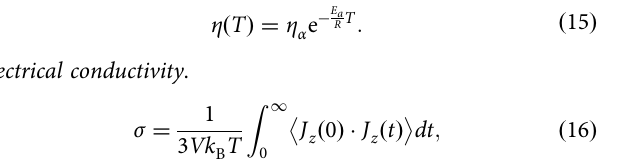
where r min the position of the fi rst valley in the PRDF.